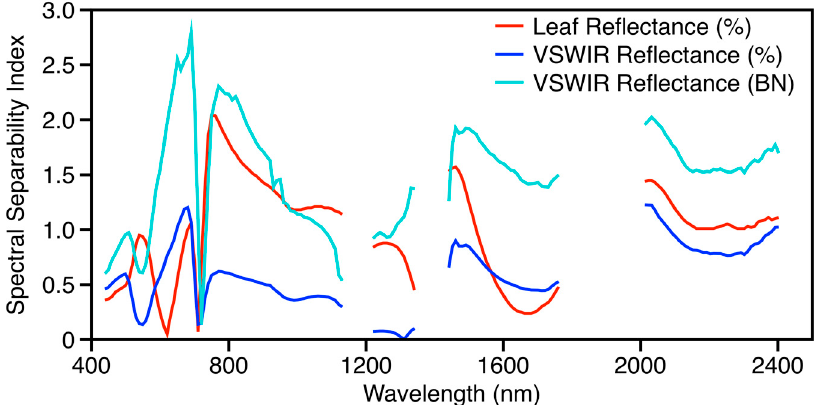
Figure 7. Spectral separability indices between green and brown for leaf (red line) and canopy (blue line) reflectance spectra. The separability index for canopy reflectance following brightness normalization (BN) is also provided (cyan line).